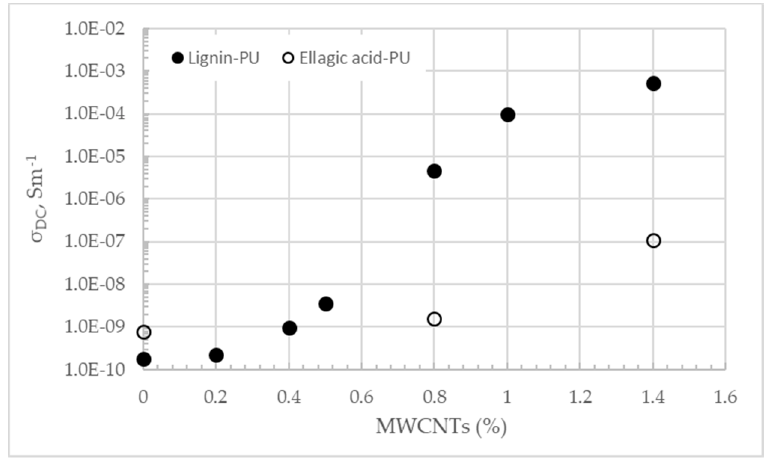
Figure 1. DC electrical conductivity σ DC at constant temperature (293 K) as a function of the MWCNTs concentration of the LignoBoost ® kraft lignin and ellagic acid-based polyurethanes.